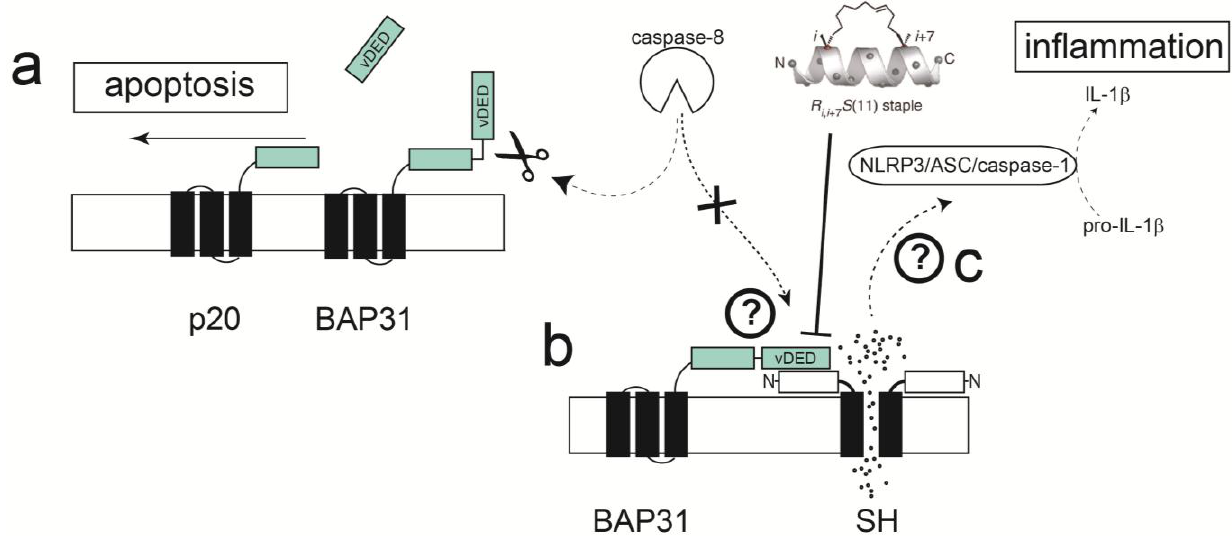
Figure 6. Schematic depicting a hypothetical model for apoptosis delay through interaction of SH and BAP31 proteins. ( a ) Activation of caspase 8 via TNF-α or other effectors cleaves the cytoplasmic vDED domain of BAP31, producing pro-apoptotic p20; ( b ) SH protein may bind to various proteins in this pathway, e.g., BAP31, blocking its cleavage by caspase-8; ( c ) ion channel activity through SH protein may contribute to production of IL-1β through activation of the inflammasome.